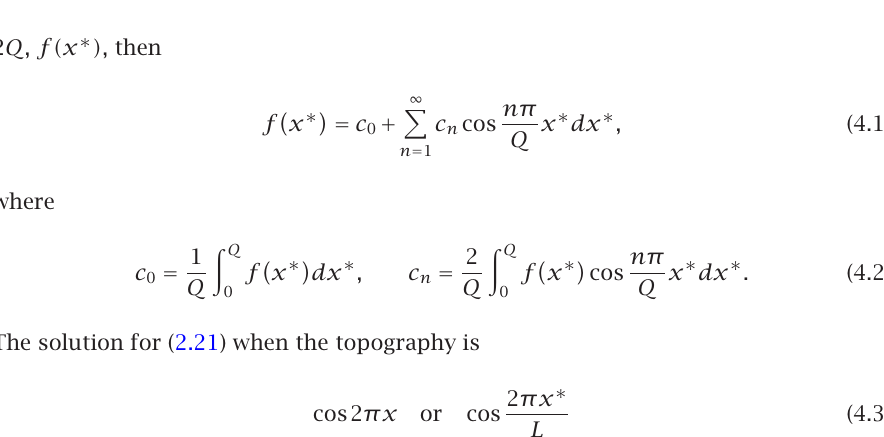
(x,t) , t (cid:2) 1. Comparisons of h Figure 3.5 . h 1 turbation approach. h 0 = 1, β = 0 .